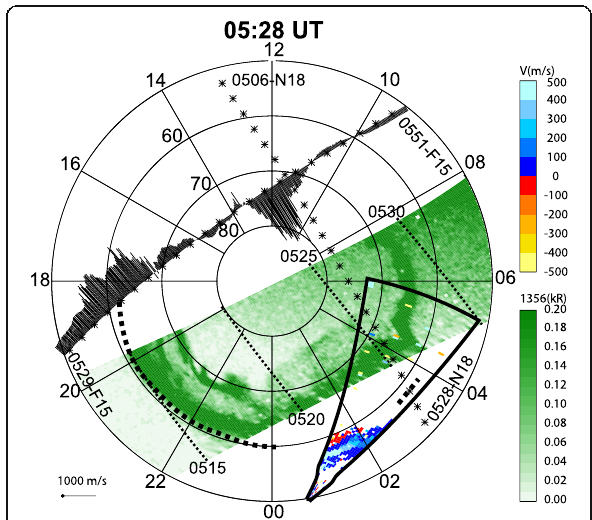
Fig. 11 LOS Doppler velocity for a 1-min scan of WAL showing a strong sub-auroral westward flow channel. Overlaid is a swath of the 135.6 nm aurora from TIMED GUVI, cross-track drift velocity from the DMSP F15 spacecraft, and the track of the NOAA-18 spacecraft, which are used to determine the equatorward edge of electron precipitation (shown as a thick dotted line). Adapted from Fig. 1 of Oksavik et al.